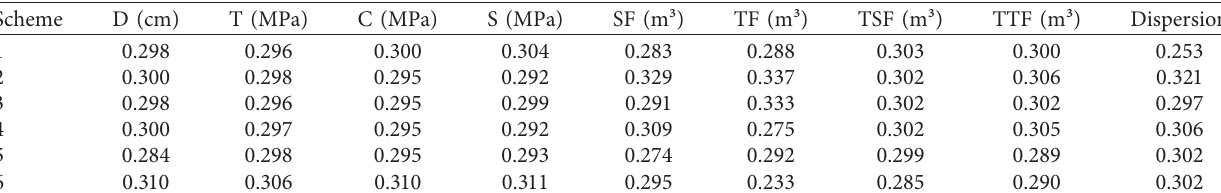
Table 5: Coordination entropy values of basic elements of six schemes.